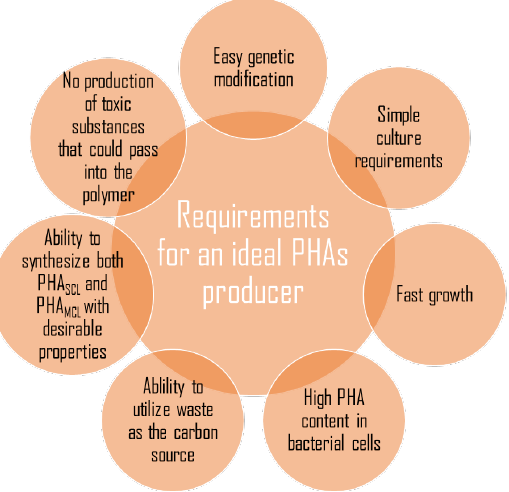
Figure 1. Characteristics of an ideal microorganism that could be used for a large scale production of polyhydroxyalkanoates.